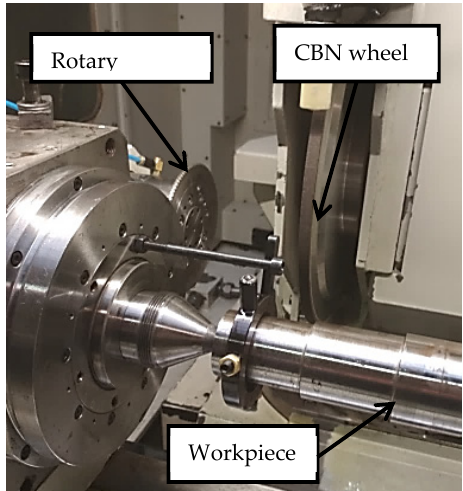
Figure 3. Dressing and grinding test set up. Figure 3 . Dressing and grinding test set up.